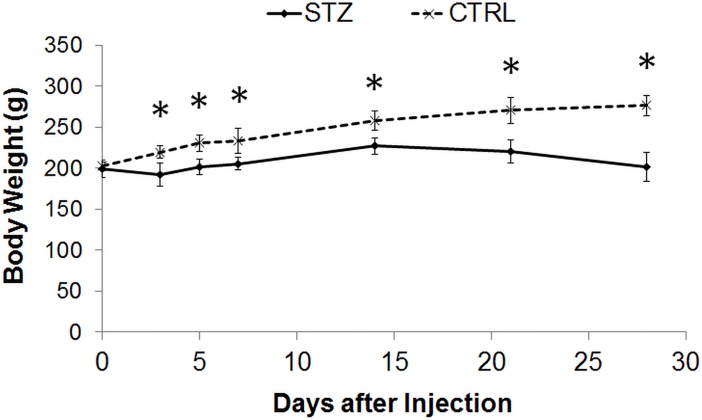
Body weights of streptozotocin-induced diabetic rats (STZ) and sham control (CTRL) rats before, and at 3, 5, 7, 14, 21 and 28 days after experimental model induction via systemic drug injection.Both groups increased their body weights over time (Repeated measures ANOVA, p<0.0001), whereas the STZ group consistently showed lower weight gain than the CTRL group after systemic drug administration (Post-hoc Sidak’s multiple comparisons correction tests, *p<0.0001).